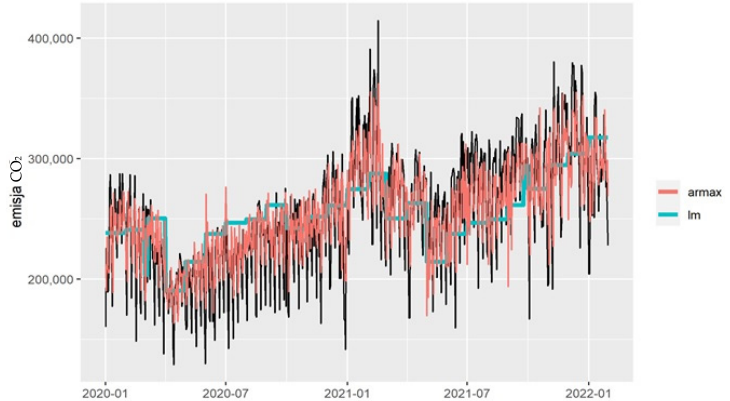
Figure 5. Identification of CO 2 emissions using a linear regression model and ARMAX model.